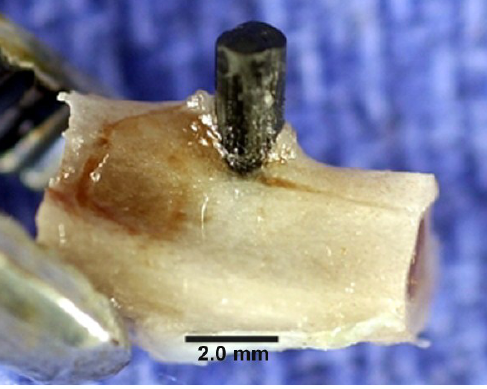
Figure 7. Photograph of epoxy/carbon fiber composite extending above tibial cortical bone with bone stimulated sufficiently to further grow upward along the side of the PMC carbon-fiber